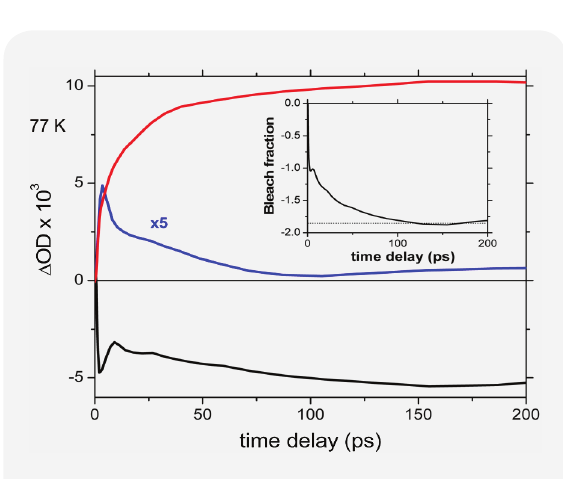
Figure 2. Transient absorption of 1,3-diphenylisobenzofuran. Red: triplet, blue: excited singlet, black: ground state bleach and